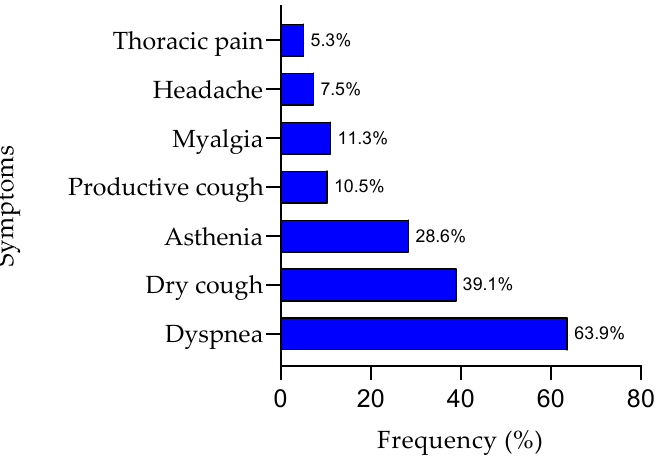
Figure 2. The graph shows the prevalence of symptoms at hospital admission expressed as percent- age.